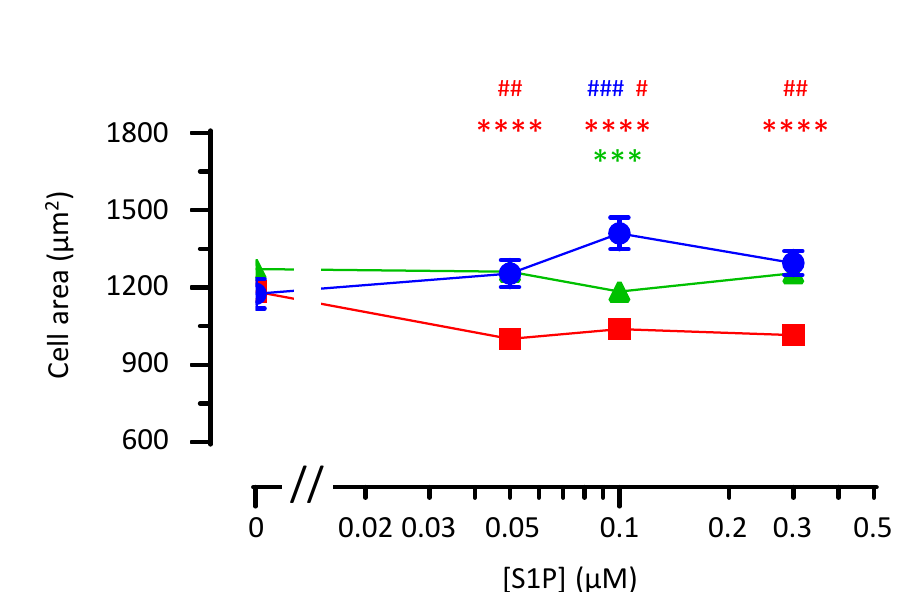
Figure 5. P-Rex1 is required for the maintenance of neurite protrusions and spreading in S1P-stimulated PC12-S1PR1 cells. ( A ) Representative confocal images of wild-type and P-Rex1-deficient PC12-S1PR1 cells grown on glass coverslips for 24 h, Figure 5: P-Rex1 is required for the maintenance of neurite protrusions and serum-starved overnight, and stimulated with indicated concentrations of S1P or mock stimulated, for 10 min prior to fixation. The green signal is GFP from S1PR1-GFP, while the blue signal is from Hoechst staining of the nucleus. Scale spreading in S1P-stimulated PC12-S1PR1 cells bar = 20 µ m. ( B , C ) Quantification of cell perimeter ( B ) and cell area ( C ) of cells treated as in ( A ). For image analysis, cell masks were applied using CellProfiler software, and cell perimeter and area were calculated from the masks. Data are presented as the mean ± SEM of cells pooled from three independent experiments. At least 250 cells were analysed per condition. Outliers were identified using ROUT in GraphPad Prism 8.3.1 and were removed prior to statistical analysis. Statistical analysis involved two-way ANOVA with Dunnett’s multiple comparisons test. Asterisks denote differences between P-Rex1-deficient and wild-type cells, whereas hashes denote S1P-dependent differences within one